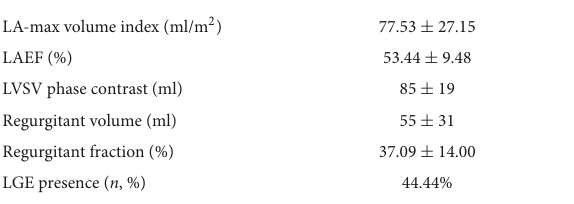
TABLE 1 Clinical features and CMRI parameters of MR patients enrolled in the study. Clinical